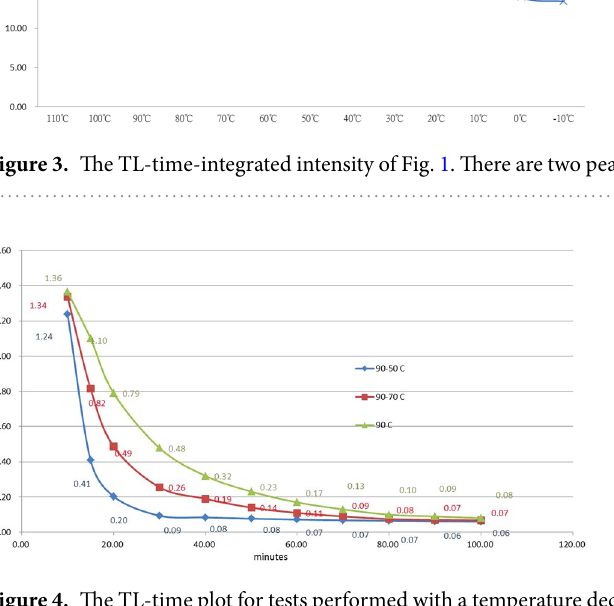
Figure 4. The TL-time plot for tests performed with a temperature decrease during the process. The top curve is the original with a constant 90 °C throughout its lifetime. The temperatures for the middle and bottom curves were decreased to 70 °C and 50 °C respectively 10 minutes after excitation was